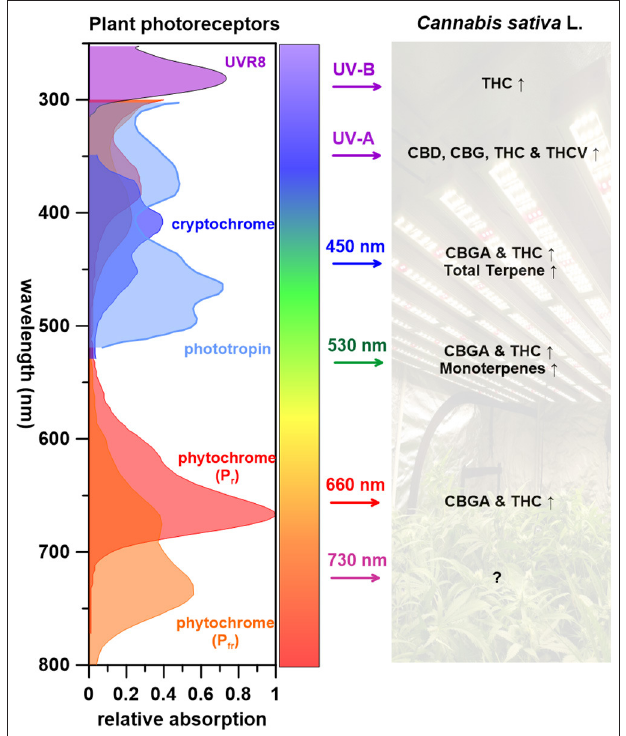
FIGURE 3 | The impact of wavelengths on Cannabis sativa L. PSM responses, with corresponding photoreceptors ( ↑ : increase, 1 : varying depended on light treatments, ↓ : decrease, ?: